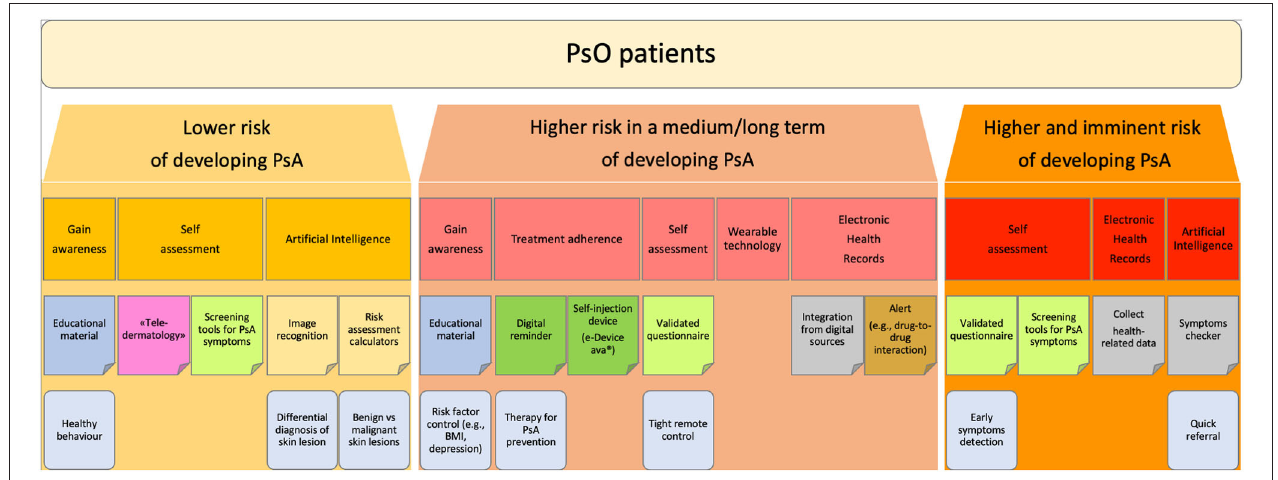
FIGURE 1 | Flowchart: stratification of PsO patients. Proposed stratification of PsO patients according to the increasing risk of developing PsA.